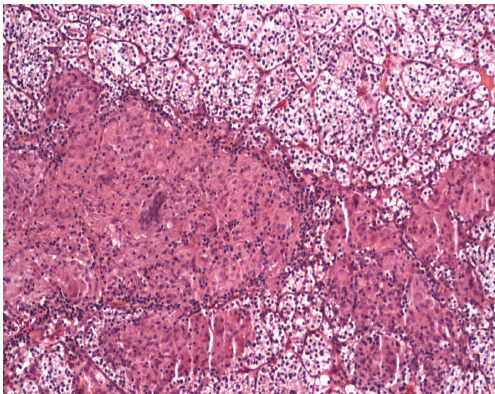
Figure 2: Variable-sized multiple epithelioid nonnecrotizing gran- ulomas within conventional renal cell carcinoma (100x magnifica- tion).